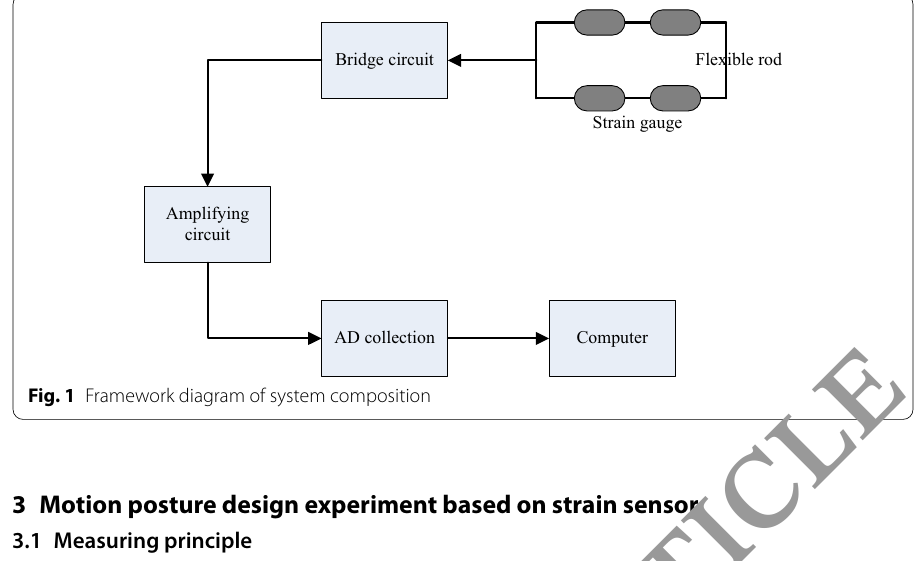
Fig. 1 Framework diagram of system